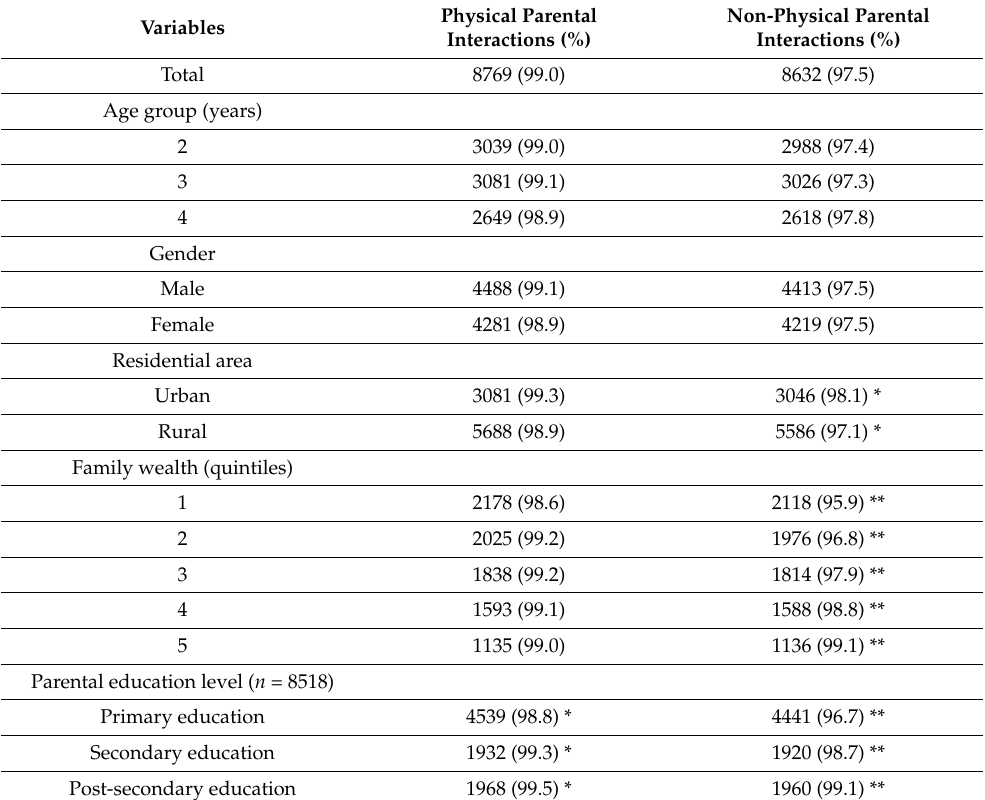
Table 2. Comparing physical and non-physical parental interactions by children personal